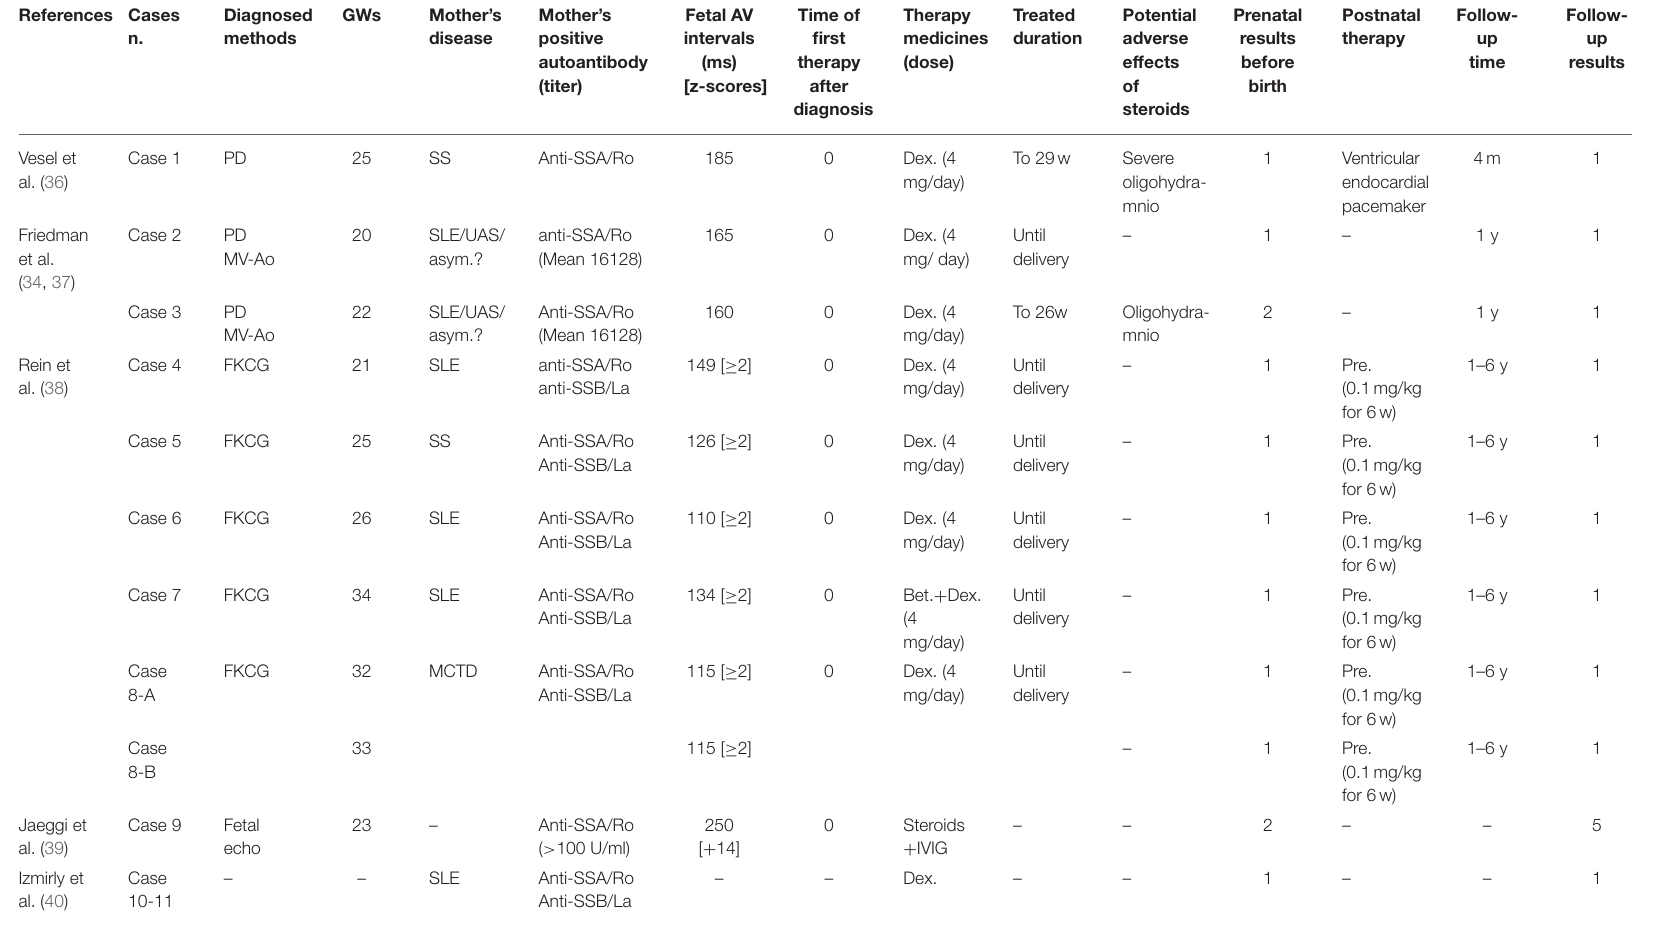
TABLE 1 | Literature summery about the initial diagnosis of fetal first-degree autoimmune-associated congenital heart block. References Cases n.